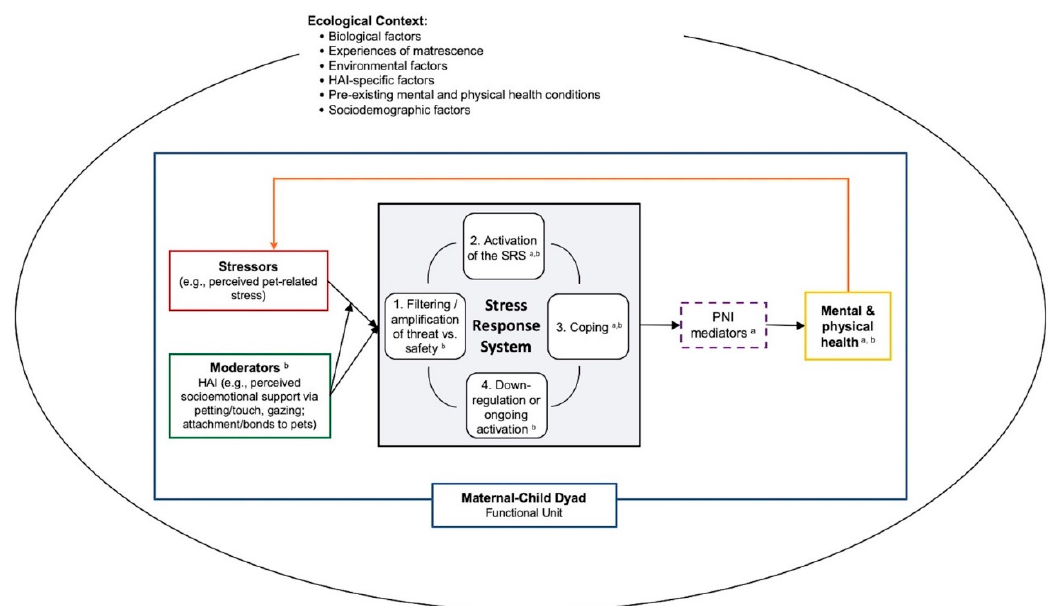
Figure 1. Human–animal focused integrative model of stress and perinatal mental health. Dashed lines reflect that PNI mediators may not always be present in the model. For space and clarity, we did not specify individual ecological factors in the figure. Some examples of biological factors may include epigenetic patterns, evolutionary history, endocrinology of selective social bonds; environmental factors may include experiences of adversity and/or discrimination (e.g., adverse childhood experiences, intimate partner violence, racism); HAI-specific factors may include location (home, community, laboratory), dosage (frequency, duration, intensity), species type, method (HAI involving household pets, HAI through animal-assisted interventions); and sociodemographic factors may include age, sexual orientation, gender identity, race/ethnicity, geographic location. HAI = human–animal interaction. SRS = stress response system. PNI = psycho–neuro–immunological. a Moyer and Kinser’s Comprehensive Model for Mental Health during the Perinatal Period. b Pendry and Vandagriff’s HAI-HPA Transactional Model.